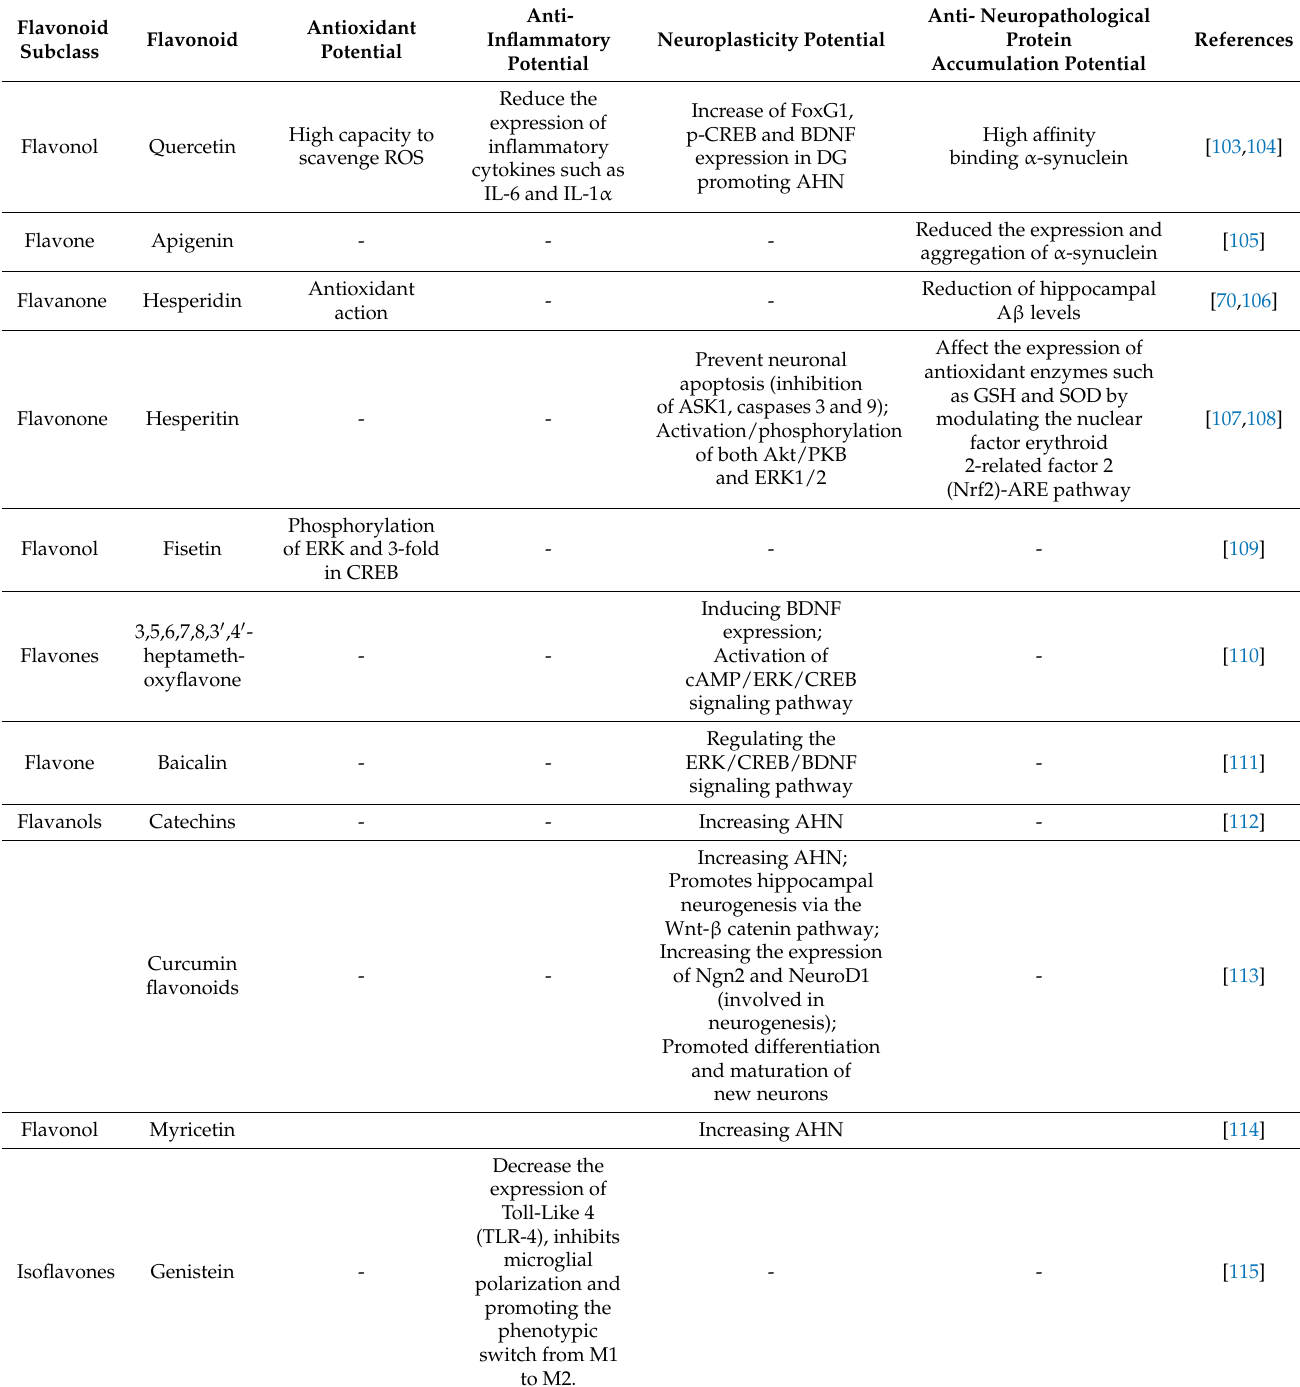
Table 2. Summary of the potential effects of some flavonoids on neurodegenerative